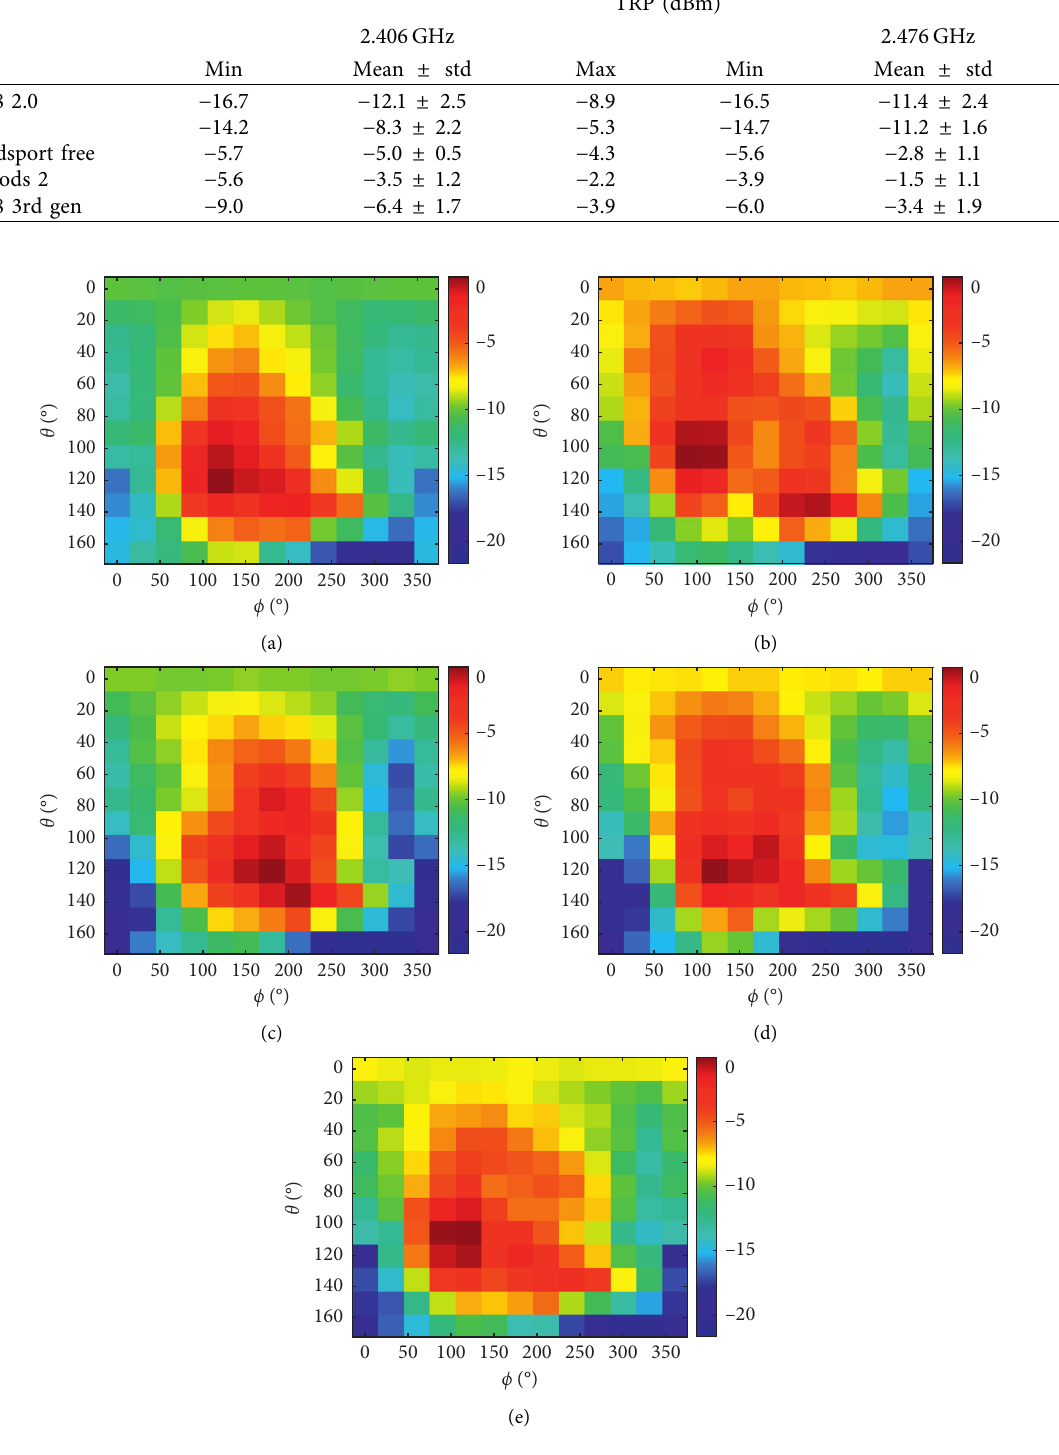
Figure 7: Normalized mean measured EIRP (in dB) radiation pattern of the right-side earbud, when placed in the right ear of the volunteer, measured at 2.406GHz: (a) Beoplay E8 2.0; (b) Earin M2; (c) Bose soundsport free; (d) Apple airpods 2; (e) Beoplay E8 3rd